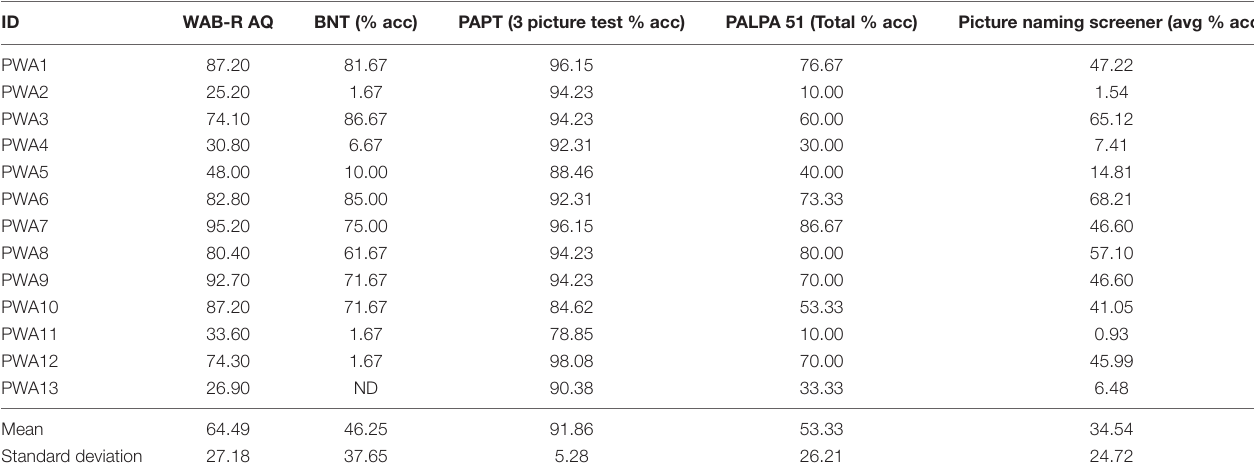
TABLE 2 | Performance on standardized language tests and other behavioral